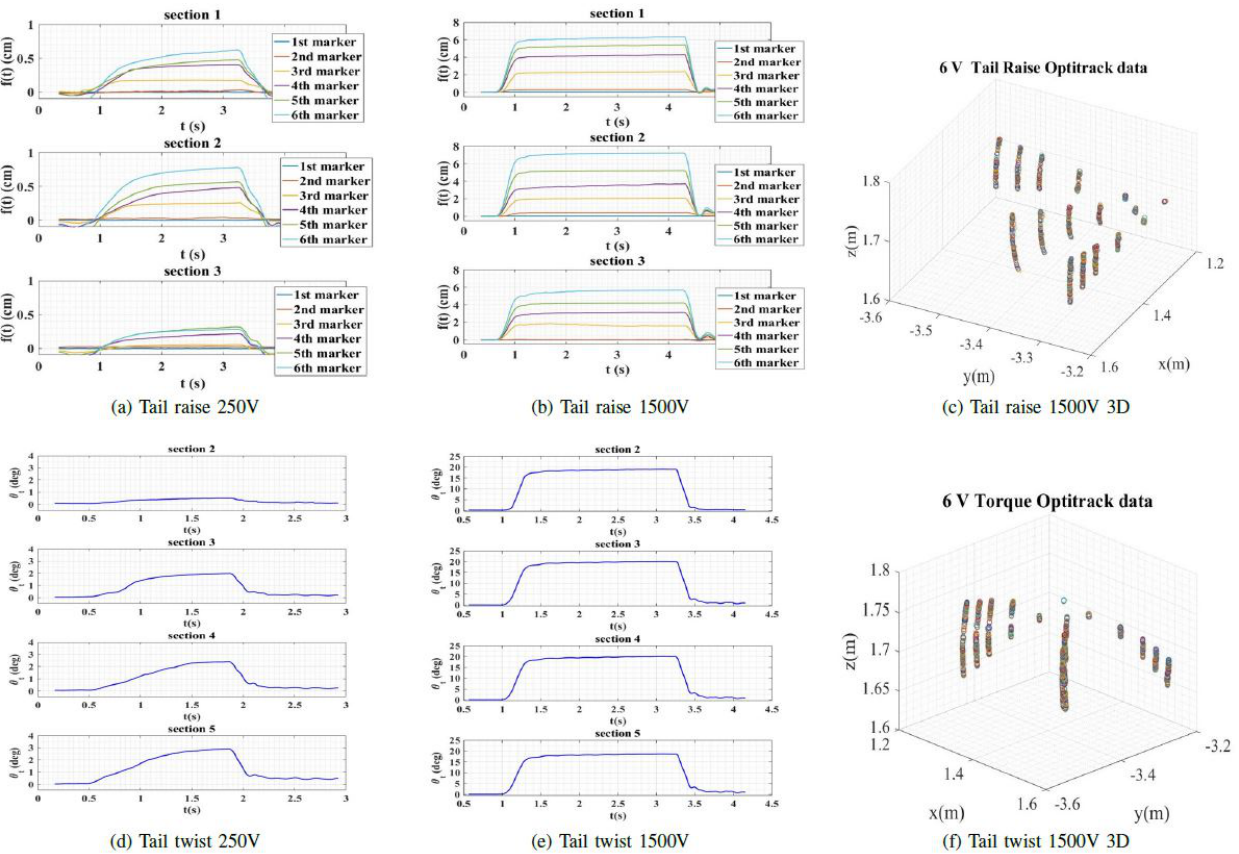
Figure 13. Optitrack experiments representation. ( a , b ) show the continuous displacement over time with 1 V in the input of the DC-DC converter corresponding 250 V in the actuator input and 6 V in the input of the DC-DC converter providing 1500 V in the actuator. ( c ) Shows a 3D representation using the markers placed on the tail in the Mocap system coordinates. ( d – f ) show the same results for the twist